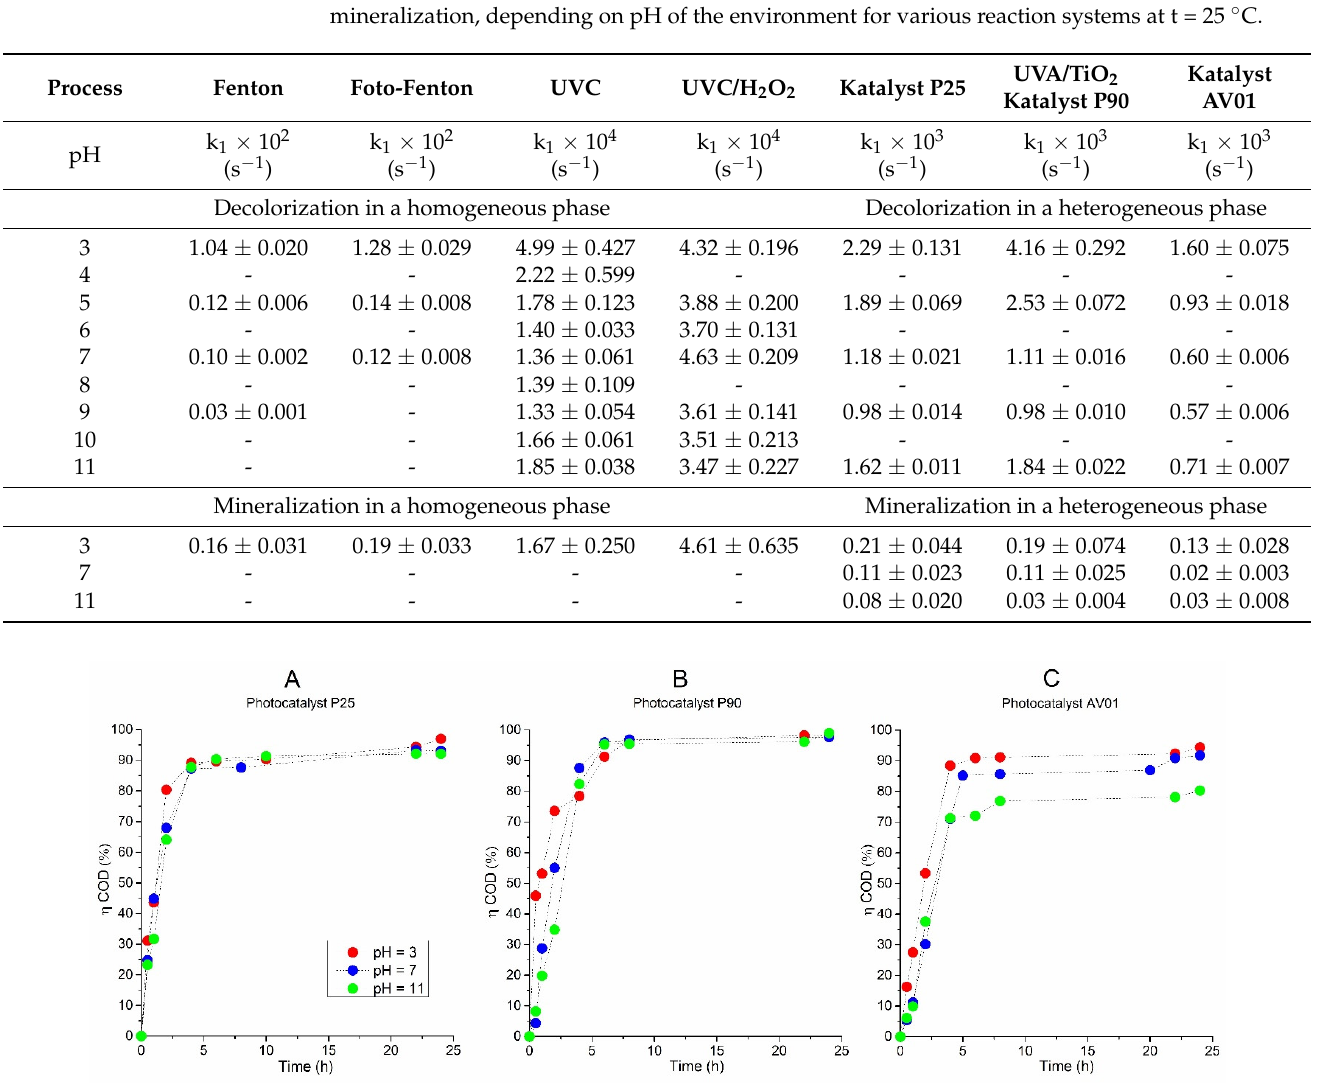
Figure 4. The efficiency of AB80 photocatalytic oxidation in the heterogeneous phase at t = 25 °C, expressed by a relative decrease in COD: ( A ) P25, ( B ) P90, ( C ) AV01.